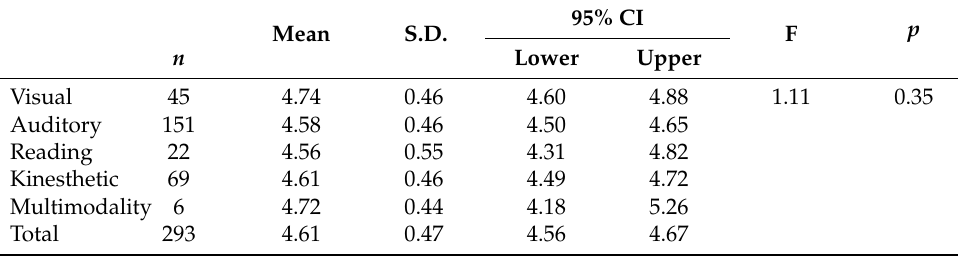
Table 2. Satisfaction of NGNs with different learning styles receiving preceptor-individualized teaching.